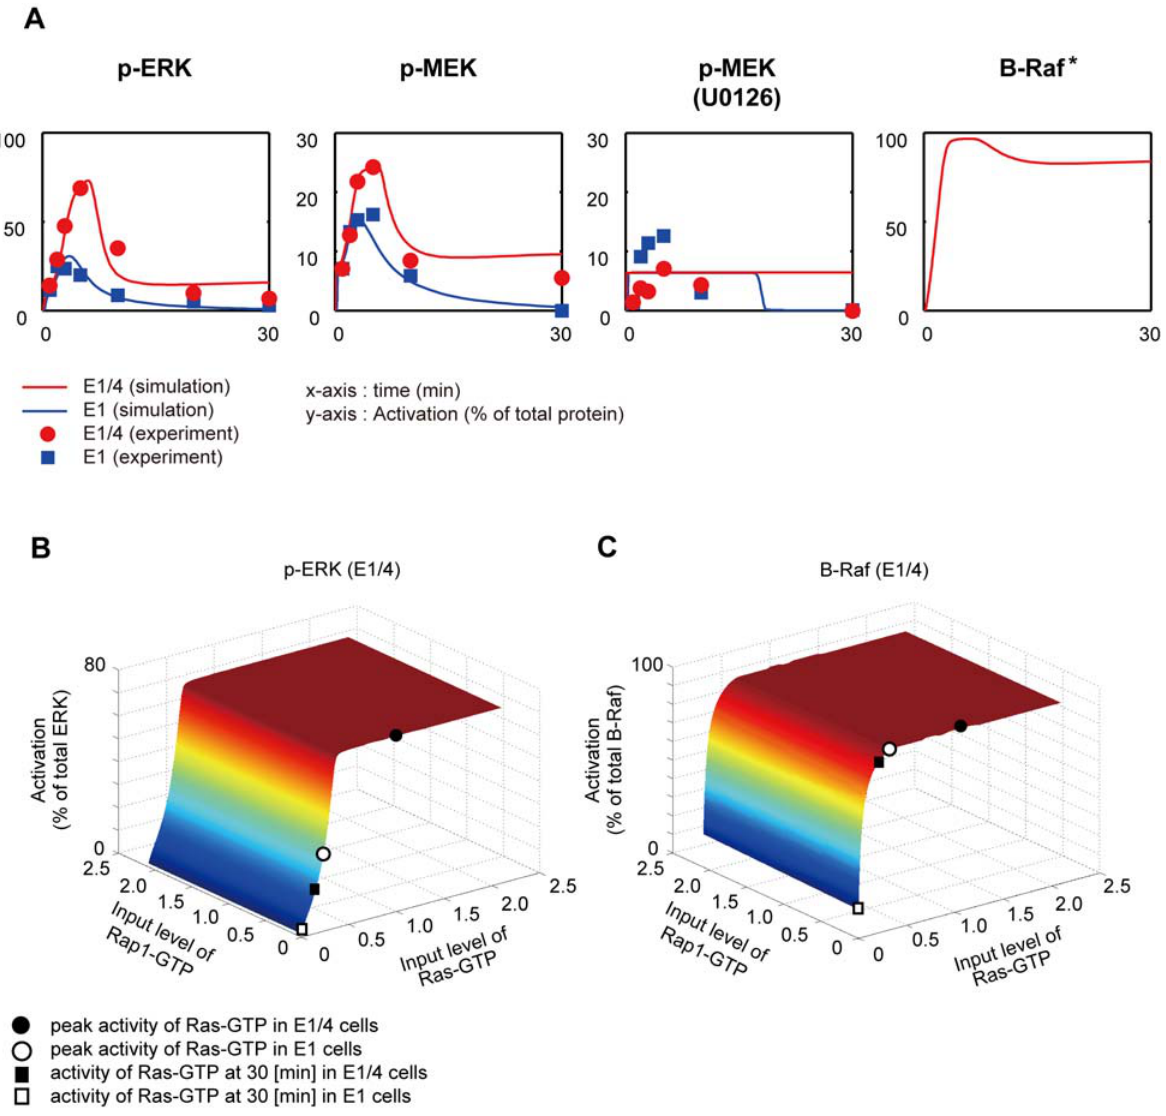
Figure 5. The time-course simulation and steady-state responses of the number 4 structure. (A) The simulation results are shown with the corresponding experimental data. Filled squares and circles indicate experimental data relating to E1 and E1/4 cells, respectively. Blue and red lines indicate the simulation data relating to E1 and E1/4 cells, respectively. The x -axis represents time (min) and the y -axis activation (% of total protein). In (B) and (C) the steady-state responses of ERK and B-Raf activity for the selected pathway structure are shown. The input signal levels of Ras- and Rap1-GTPs to the Raf-MEK-ERK cascade characterized by the number 4 structure were changed in the range 0.1 to 2.0. The simulation for each input level was then ran for 100,000 sec to approximate the steady-state values where the activity of all molecules hardly moved at about the termination time of the simulation. (B) 3-D graph of steady-state ERK activity. (C) 3-D graph of steady-state B-Raf activity. The colors of the graphs indicate activation (% of total protein). Open and filled circles correspond to the activation level induced by the input level equivalent to the peak level of Ras-GTP in E1 and E1/4 cells, respectively. Similarly, open and filled squares correspond to the activation level induced by the input level equivalent to the activity level 30 min following EGF stimulation of Ras-GTP in E1 and E1/4 cells,